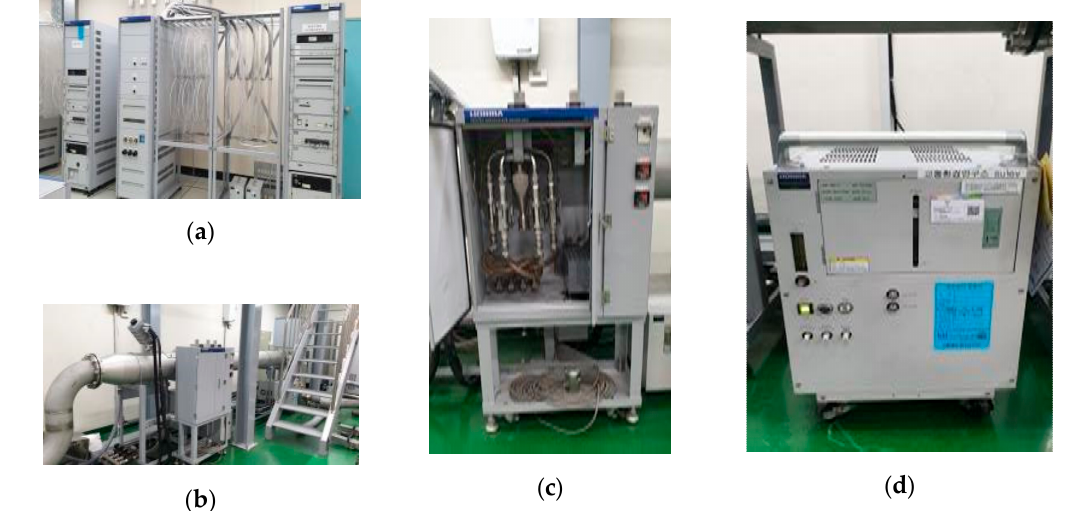
Figure 2. Experimental apparatus—Emission analyzer. ( a ) Exhaust gas analyzer; ( b ) Constant volume sampler (CVS) tunnel; ( b ) Constant volume sampler (CVS) tunnel; ( d ) Particle number measuring device. Table 5. Specifications of the test gas analyzer.